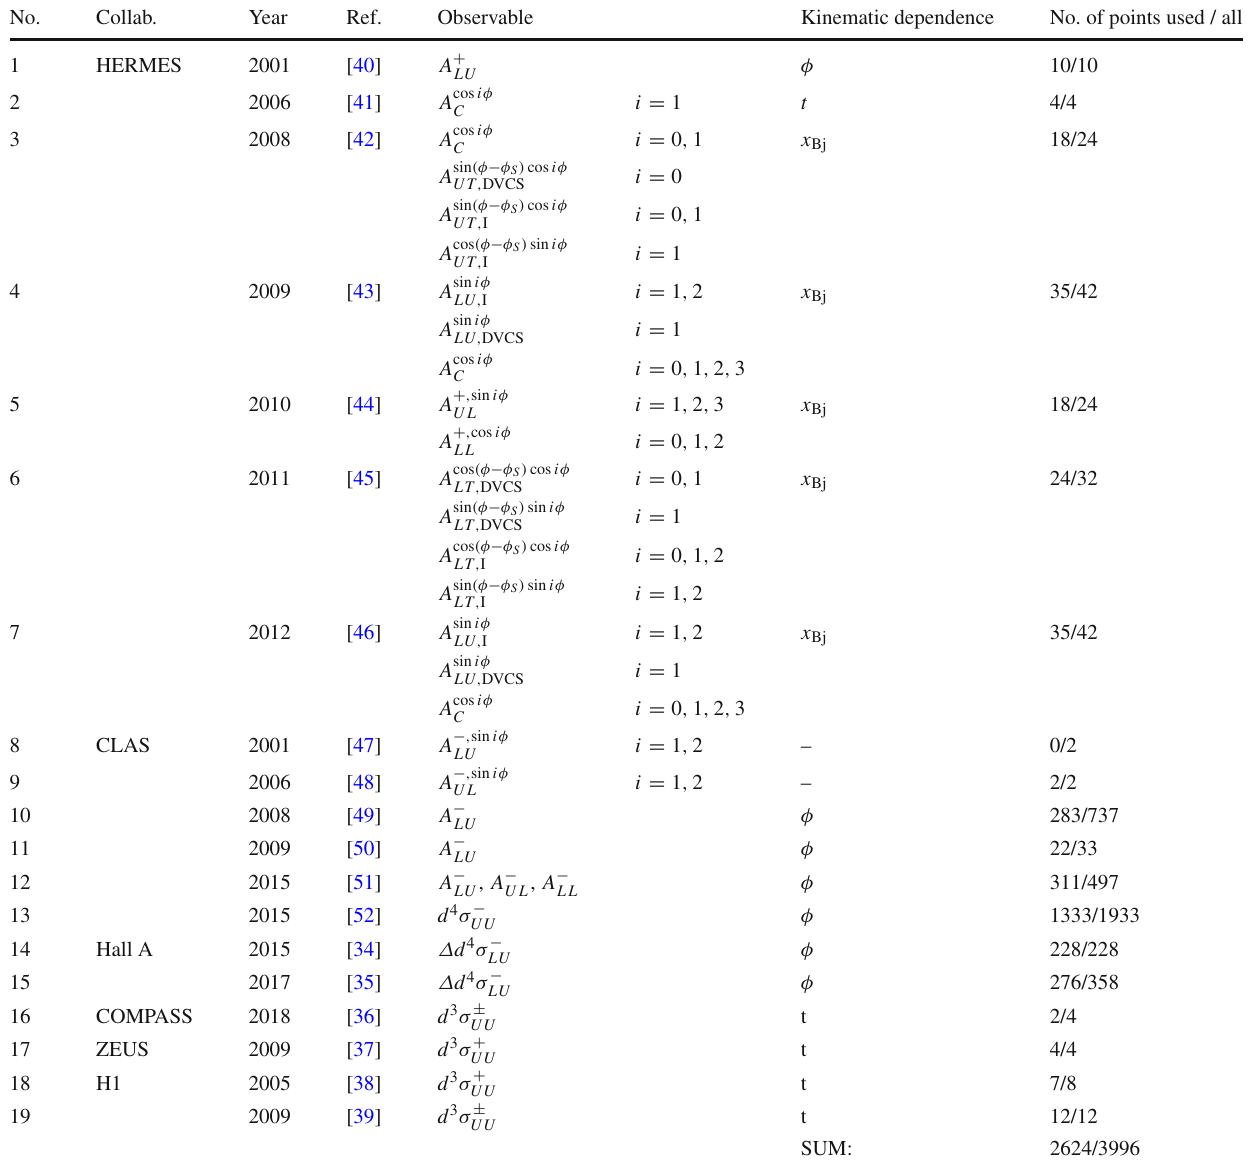
Table 2 DVCS data used in this analysis No. Collab. Year Ref. Observable Kinematic dependence No. of points used /